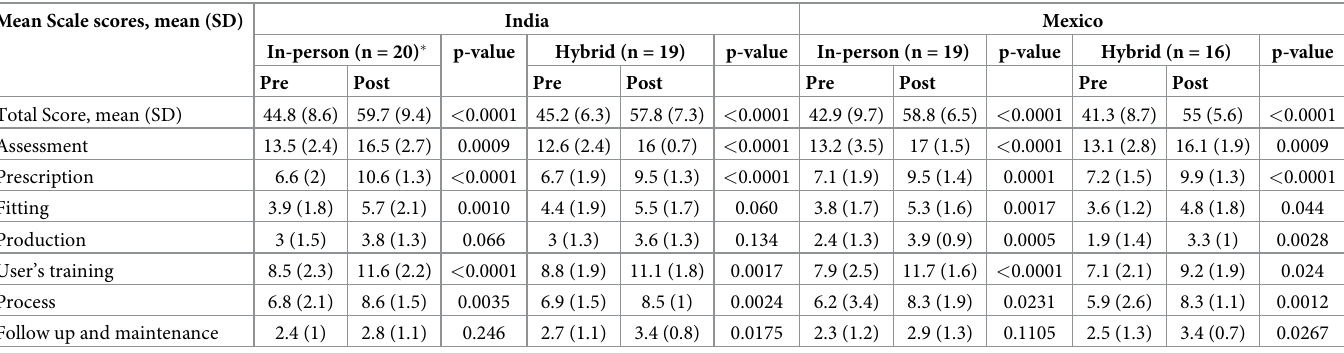
Table 5. Paired sample test scores of knowledge based on the ISWP basic test. Mean Scale scores, mean